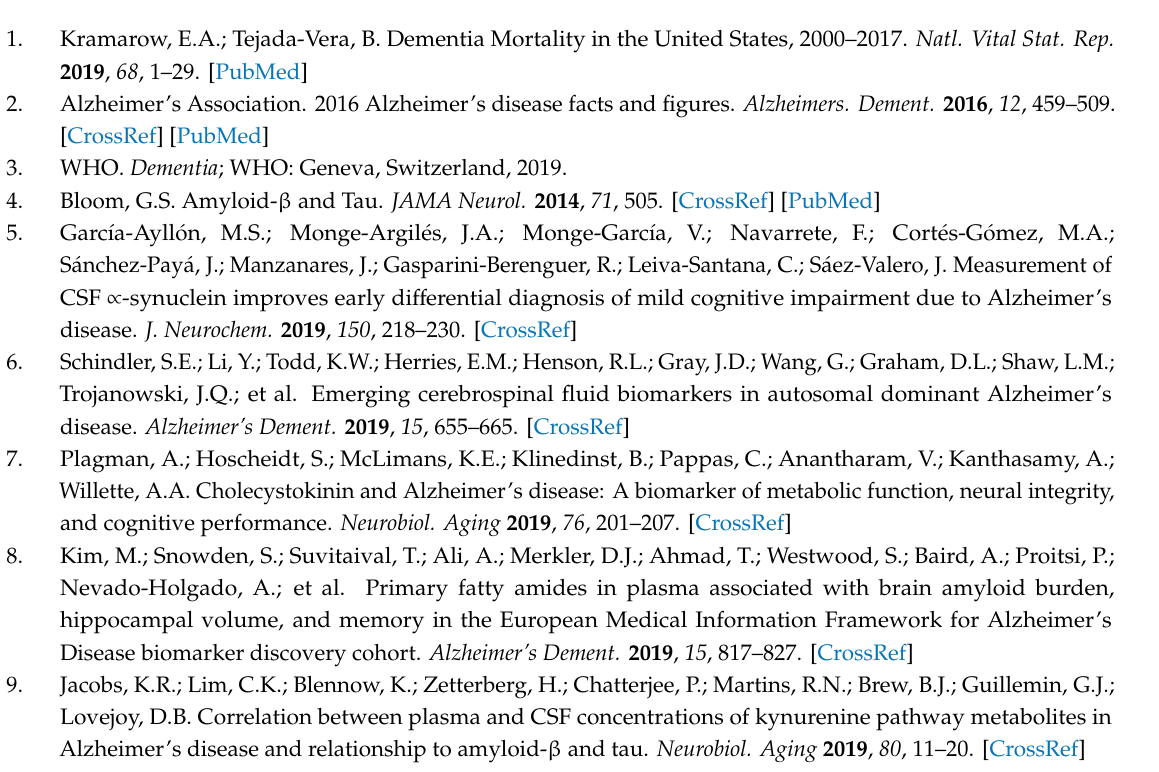
Figure S1: Chemical structures of isoprostanes, dihomo-isoprostanes, and